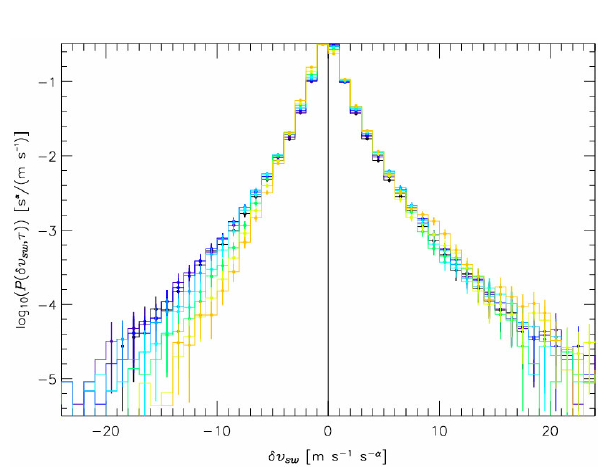
Fig. 10. Partial scaling collapse of the PDFs of δv sw for τ =64s to 8192s ( ∼ 2h) shown in Fig. 6 onto a common curve (see text). The scaling exponent α GSF =0.287 estimated from Fig. 9 was used in the mapping. Again, the error bars assume Gaussian fluctuations and are drawn at the 3 σ level.